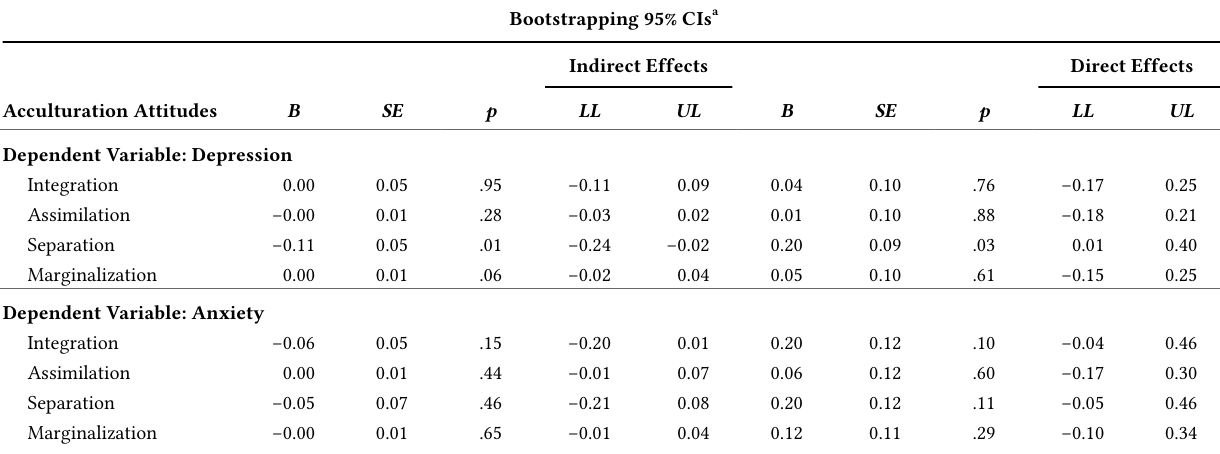
The Indirect and Direct Effects of Perceived Discrimination on Depression and Anxiety Through Acculturation Attitudes (Mediation) Bootstrapping 95% CIs a